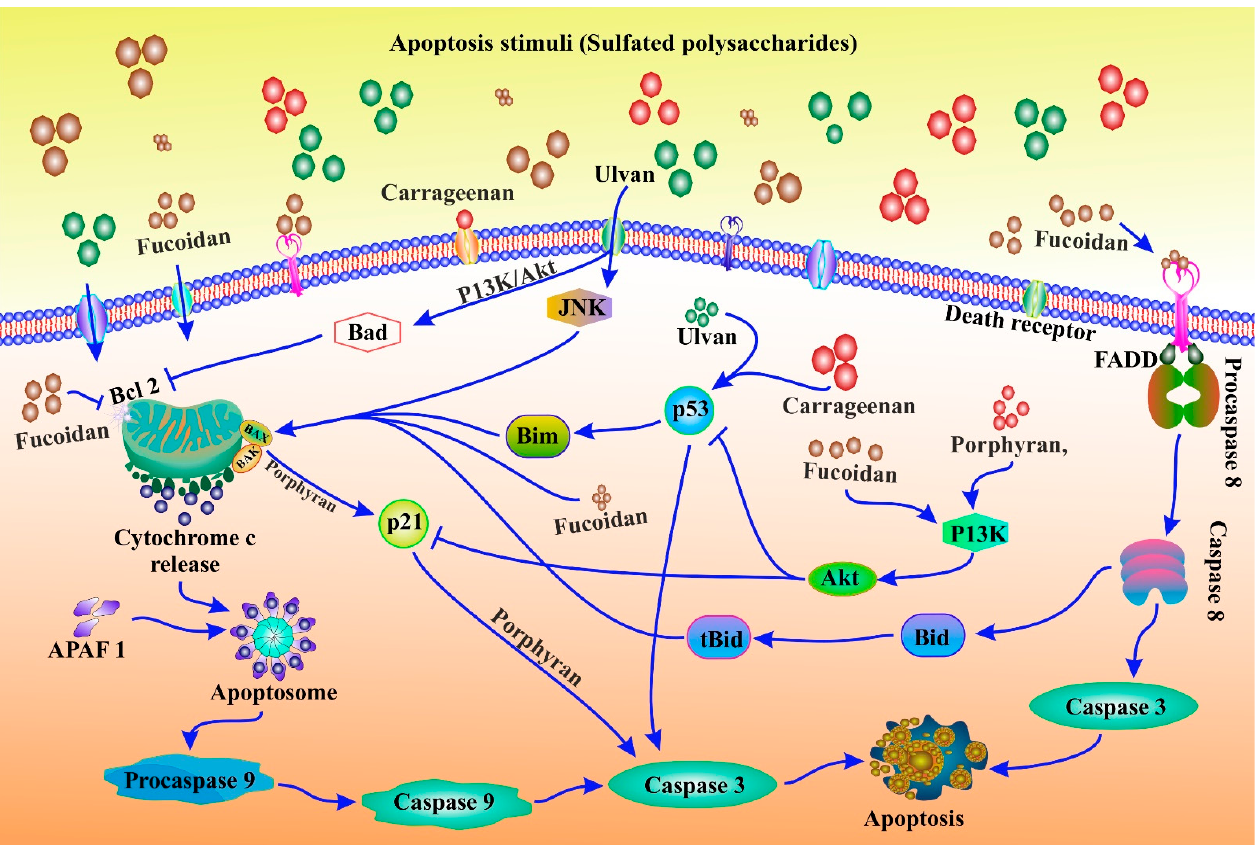
from red algae and their apoptosis modulation in cancer therapeutics are displayed in Table 3. Induction of apoptosis is the mechanism adopted by chemopreventives. Different chemopreventives. Different sulfated polysaccharides derived from different seaweeds trigger sulfated polysaccharides derived from different seaweeds trigger apoptosis in diverse apoptosis in diverse cancer cell lines (Figure 6). Sulfated polysaccharides displayed different cancer cell lines (Figure 6). Sulfated polysaccharides displayed different chemopreventive chemopreventive roles in cancer (Figure 7). roles in cancer (Figure 7).